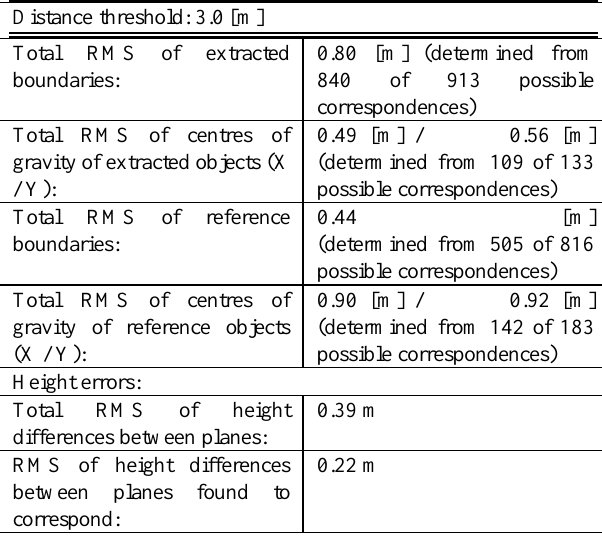
And a few images that visualize these results are also provided. Two of these images are shown below. Fig. 6 is the evaluation of building detection on a per-pixel level. In this figure, yellow means correct roofs, and blue means missed roofs, and red areas is the background but reconstructed as roofs by mistake. Fig. 7 is difference between two DSMs which were derived from the roof planes of the result and the reference